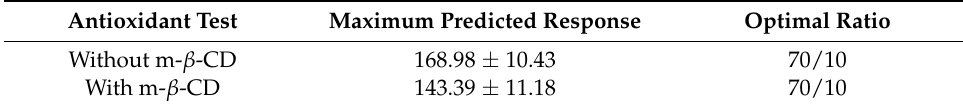
Table 4 . Optimal, predicted concentration ratios and theoretically calculated maximum response for all mixtures tested, obtained from the implementation of design.